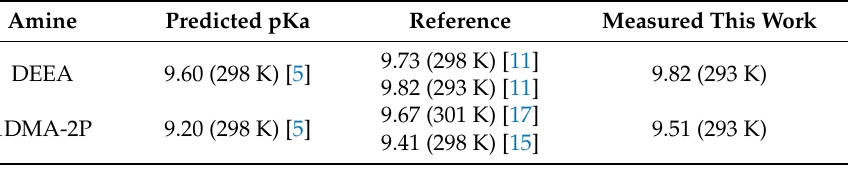
Table 1. pKa of investigates amines at 293 K and 1 atm.